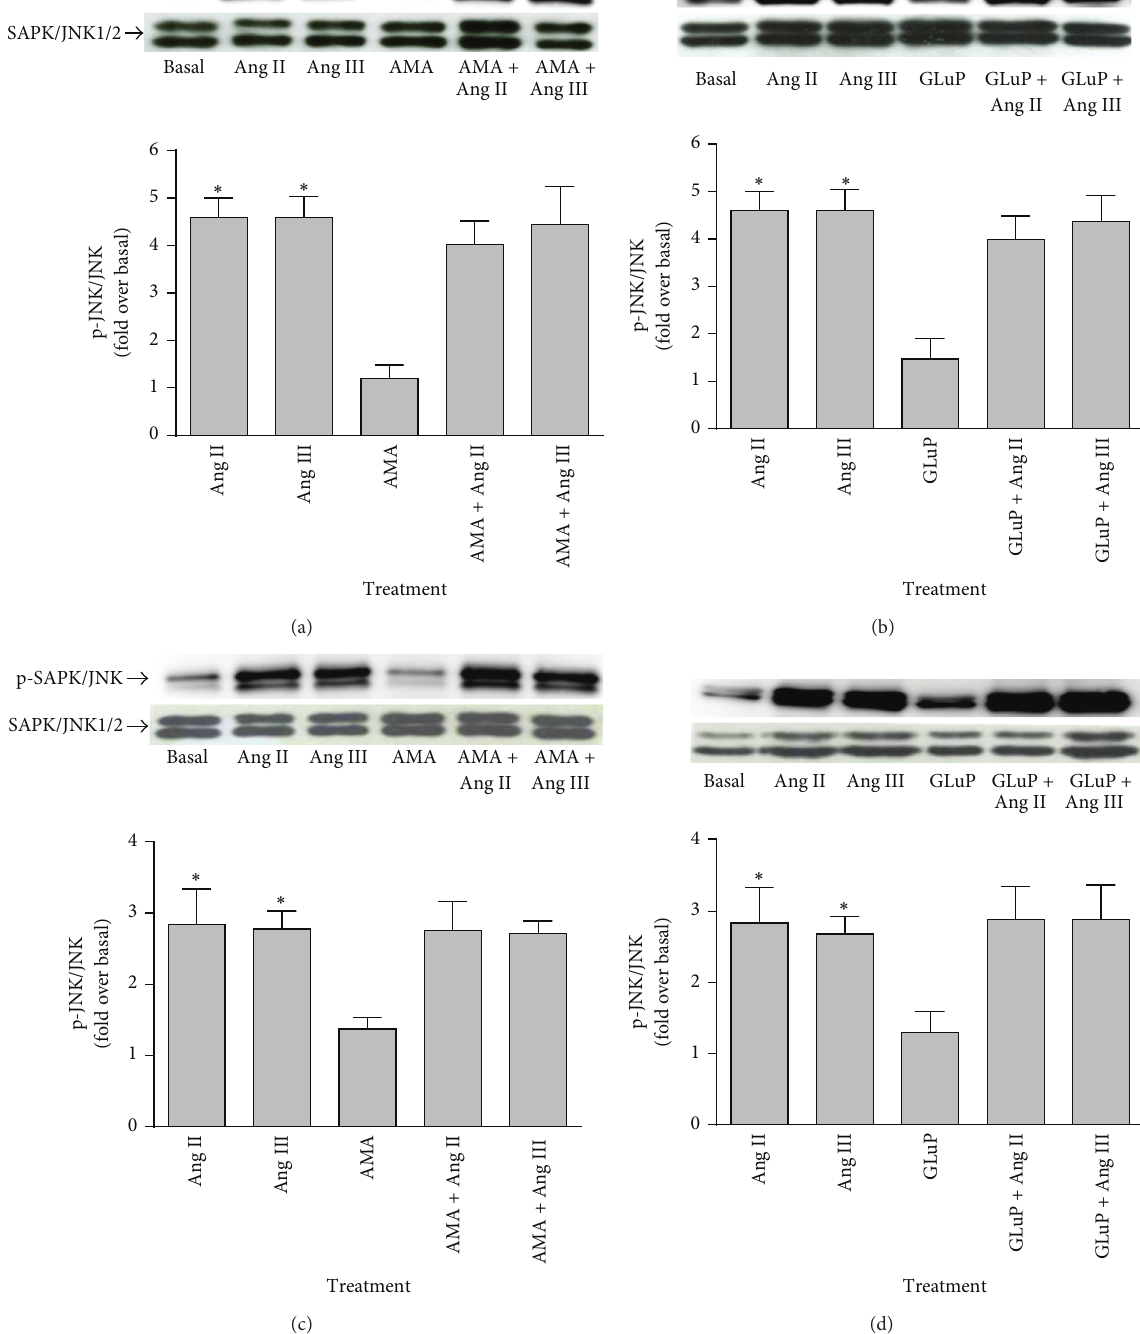
Figure 2: Effect of AMA and GluP on Ang II- and Ang III-induced SAPK/JNK protein phosphorylation. Quiescent monolayers of brainstem ((a) and (b)) and cerebellum ((c) and (d)) astrocytes were pretreated with 10 𝜇 M AMA or 100 𝜇 M GluP for 15 minutes. The cells were subsequently stimulated with 100nM Ang II or 100nM Ang III for 10 minutes. Phosphorylated-SAPK/JNK immunoreactive protein levels were measured by Western blot analysis using an antibody specific for the phosphorylated form of SAPK/JNK. Protein loading was quantified using the SAPK/JNK protein antibody. The data were analyzed by densitometry, and the amount of phosphorylation was calculated as the fold increase over basal in the presence of vehicle. Each value represents the mean ± SEM of preparations of brainstem and cerebellum astrocytes from 6 or more litters of neonatal rat pups. ∗ denotes that 𝑃 < 0.05 as compared to basal levels for SAPK/JNK expression in astrocytes prepared from the brainstem and the